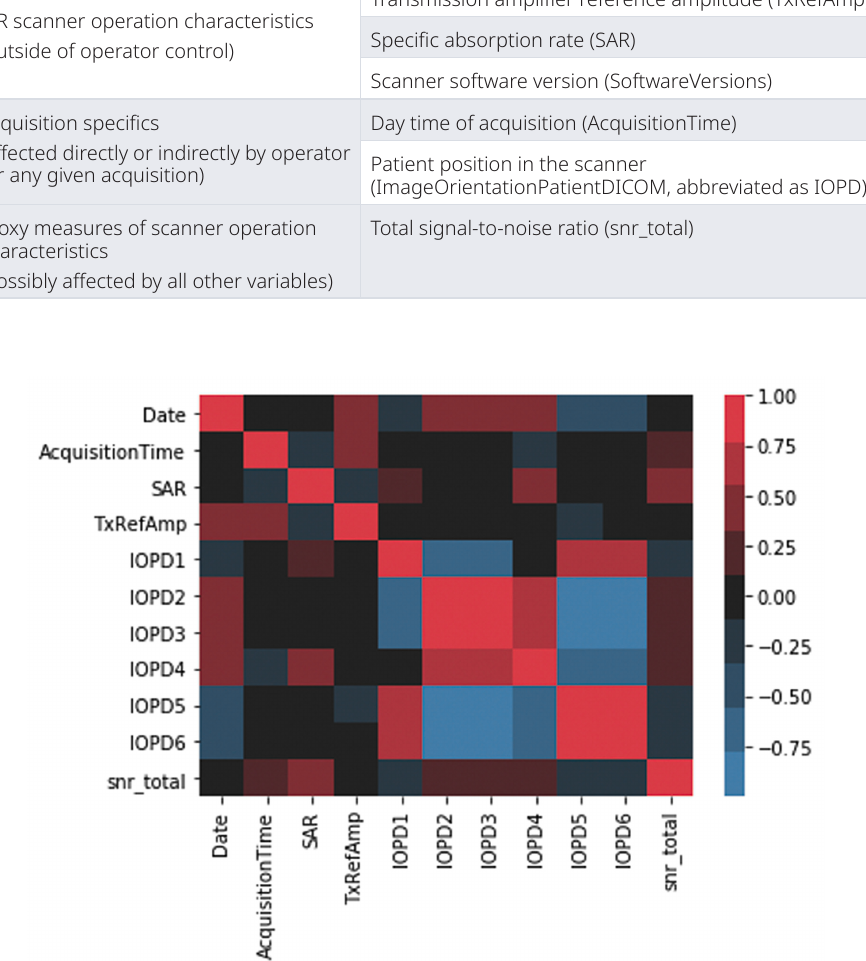
Figure 1. Pearson correlations between different variables on phantom MRI phantom data. Refer to Table 1 for explanation of abbreviated